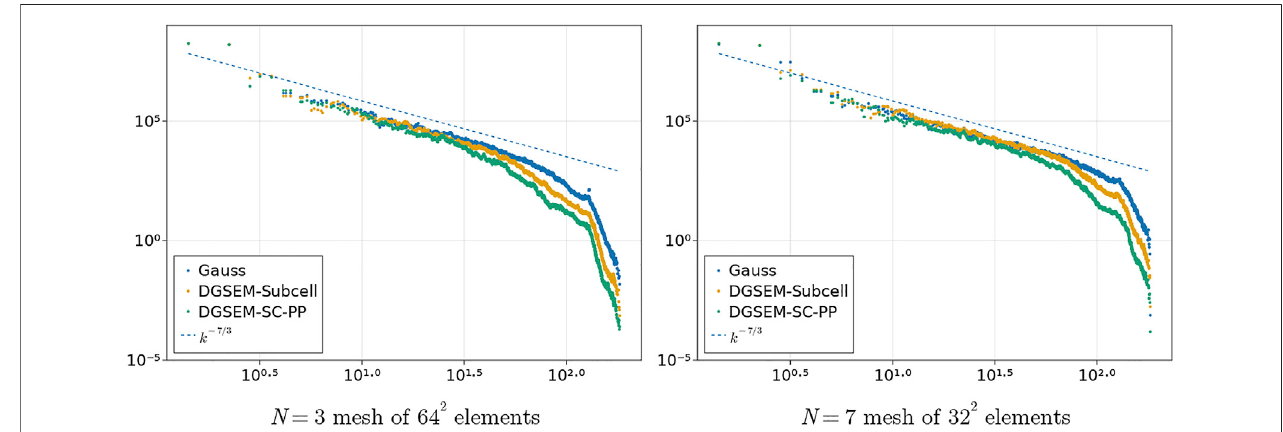
FIGURE 12 | Weighted power spectra for DGSEM-Subcell, entropy stable DGSEM-SC-PP, and entropy stable Gauss DG